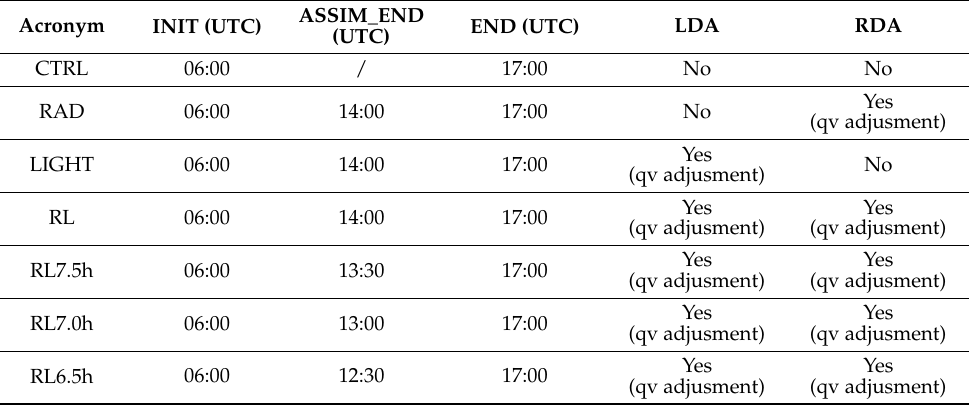
Table 3. RAMS@ISAC simulations. All simulations refer to the 15 July 2020. The INIT column shows the simulation start time, ASSIM_END shows the end of the assimilation phase, END is the simulation ending time. The LDA column shows if lighting is assimilated, and the parameter adjusted. The RDA column shows if radar data are assimilated, and the parameter